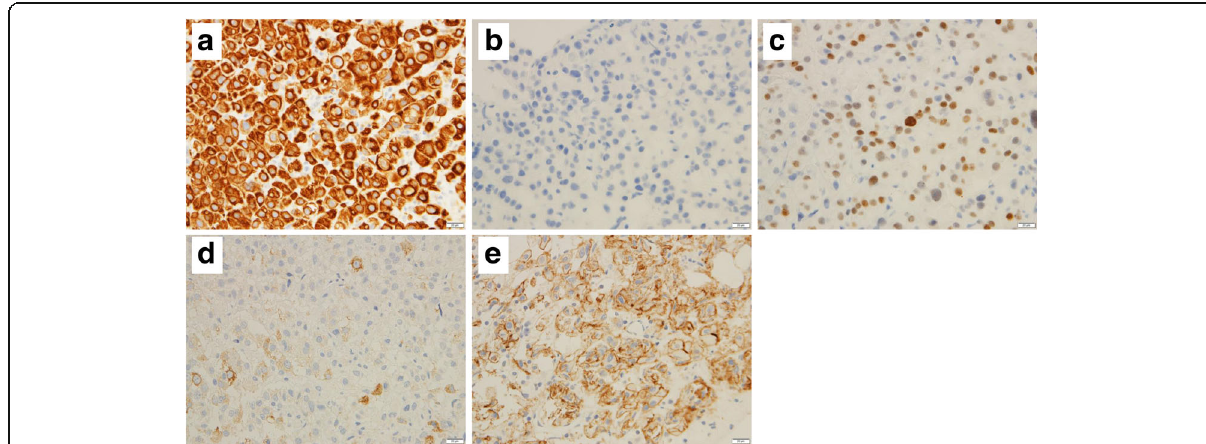
Fig. 3 Immunohistochemical findings. Immunohistochemically, the tumor cells were positive for CK-7 ( a ) but negative for CK-20 ( b ). ER ( c ), GCDFP-15 ( d ), and HER2 ( e ) were positive. All scale bars, 20 μ